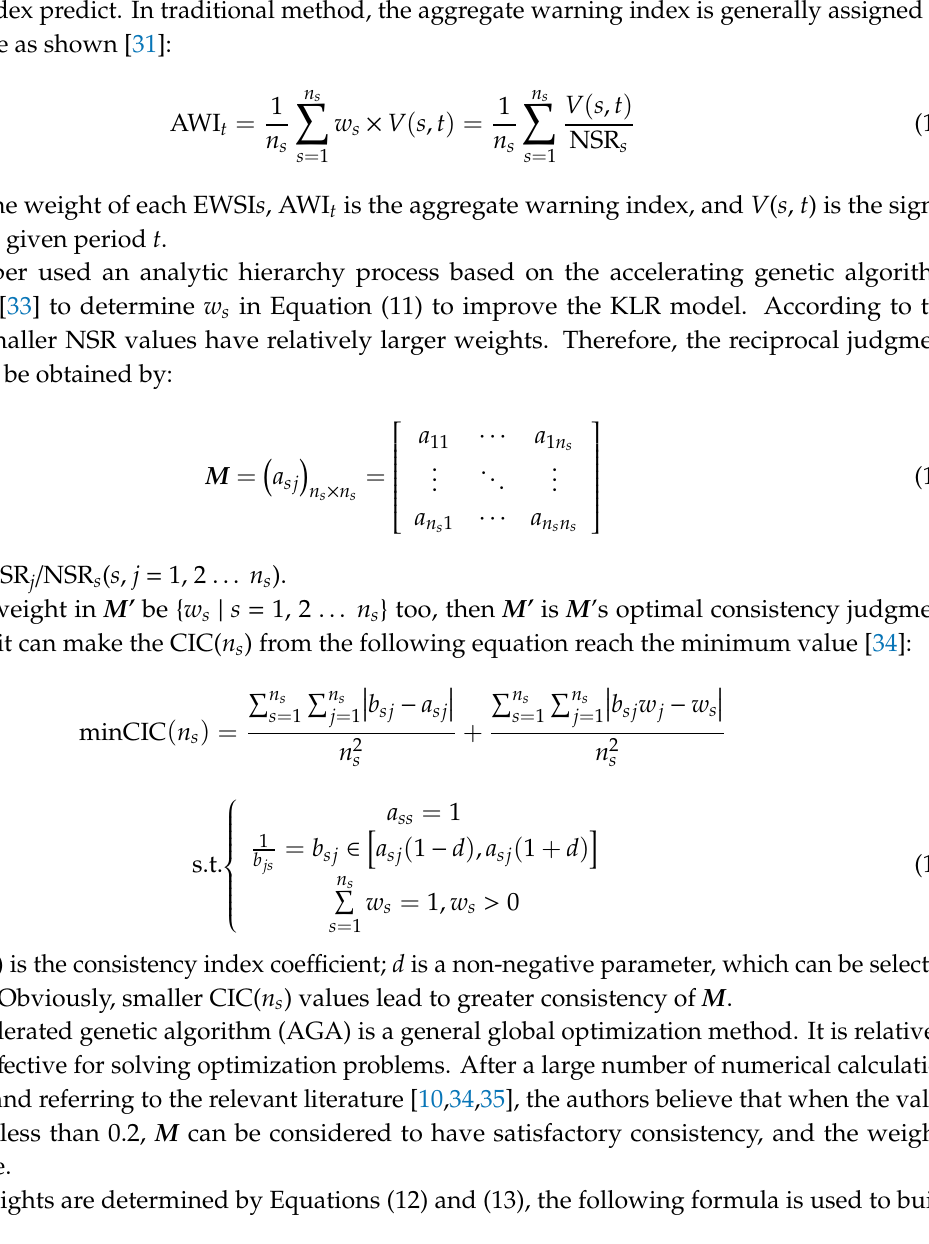
Table 1. Performance criteria of early warning sign index (EWSI) for early warning system for regional water resources carrying capacity (EWS-RWRCC). Crisis Occurs in the Next Year No Crisis Occurs in the Next Year Index sends out signal A B Index does not send out signal C